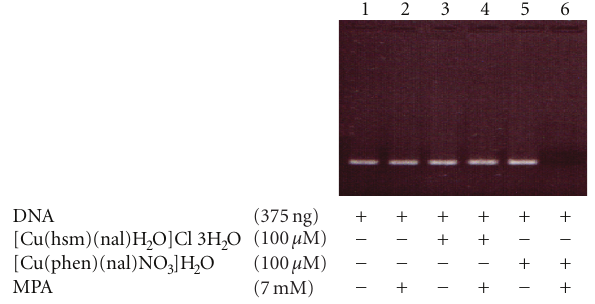
Figure 4: Activity of [Cu(hsm)(nal) H 2 O]Cl · 3H 2 O for cleavage of plasmid DNA. 375ng of 196 bp DNA were incubated with (lanes 3, 4) or without (lanes 1, 2) [Cu(hsm)(nal)H 2 O]Cl · 3H 2 O (100 μ M) or with (lanes 5, 6) [Cu(phen)(nal)H 2 O]NO 3 · 3H 2 O (100 μ M) in presence (lanes 2, 4, 6) or absence (lanes 1, 3, 5) of mercapto propionic acid, (MPA) (7Mm), for 50 minutes at 37 ◦ C.